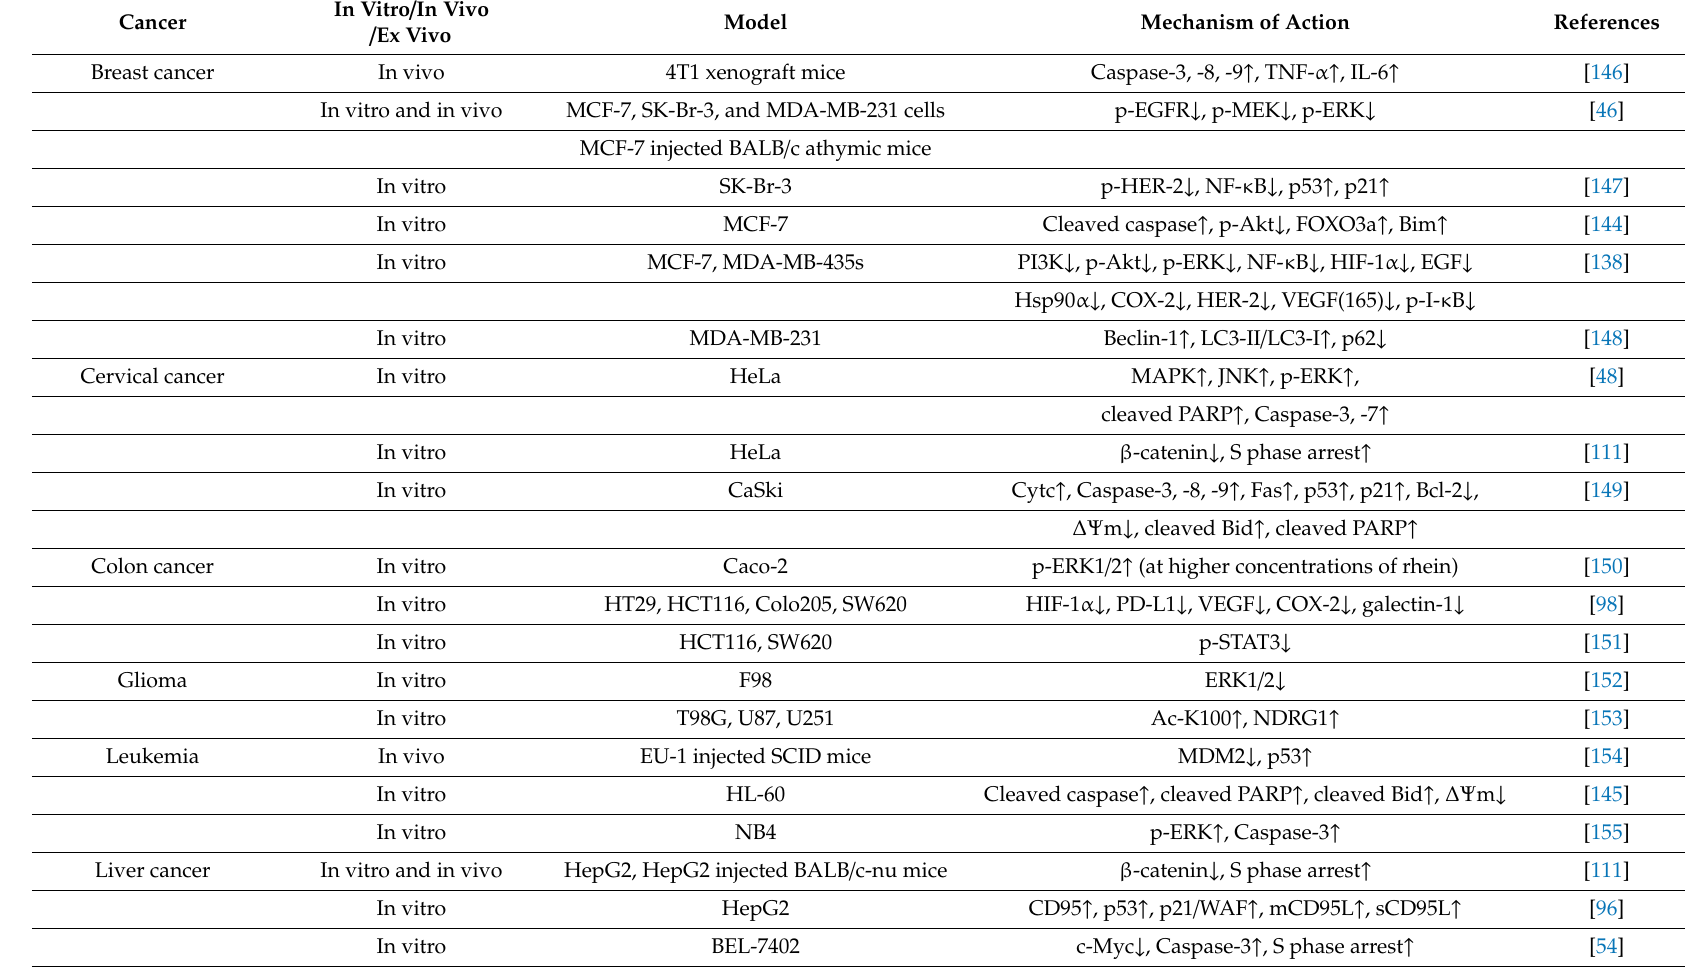
Table 1. Chemopreventive activity of rhein in di ff erent